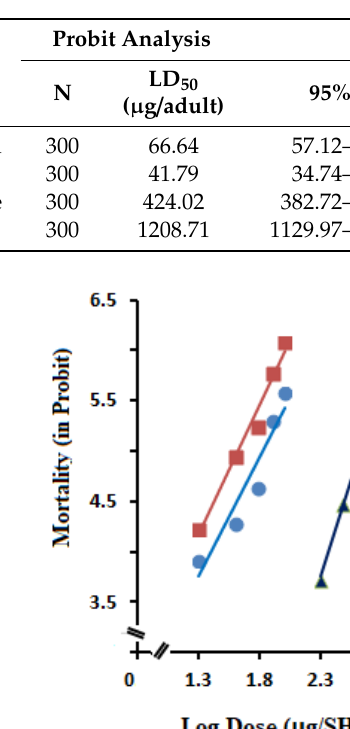
Table 2. Lethal dose (LD 50 ) and 95% confidence limits (CL) estimated for the small hive beetles 24h after topical application of T. ammi essential oil and its three main constituents.